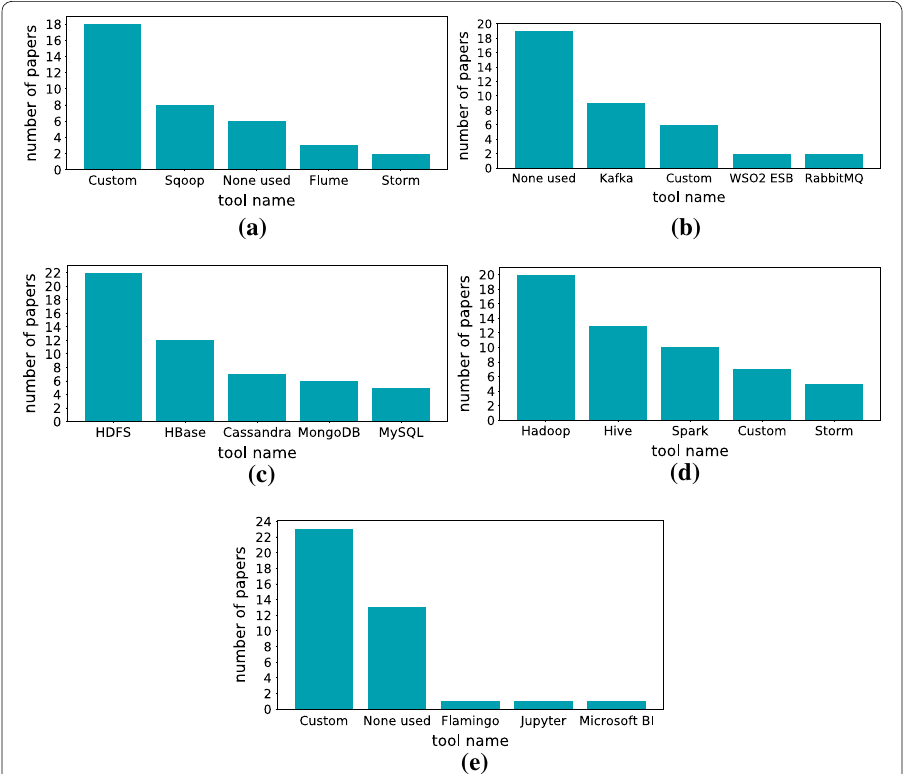
Fig. 7 The top 5 tools used for a ingestion, b communication, c storage, d analysis, and e visualization in the